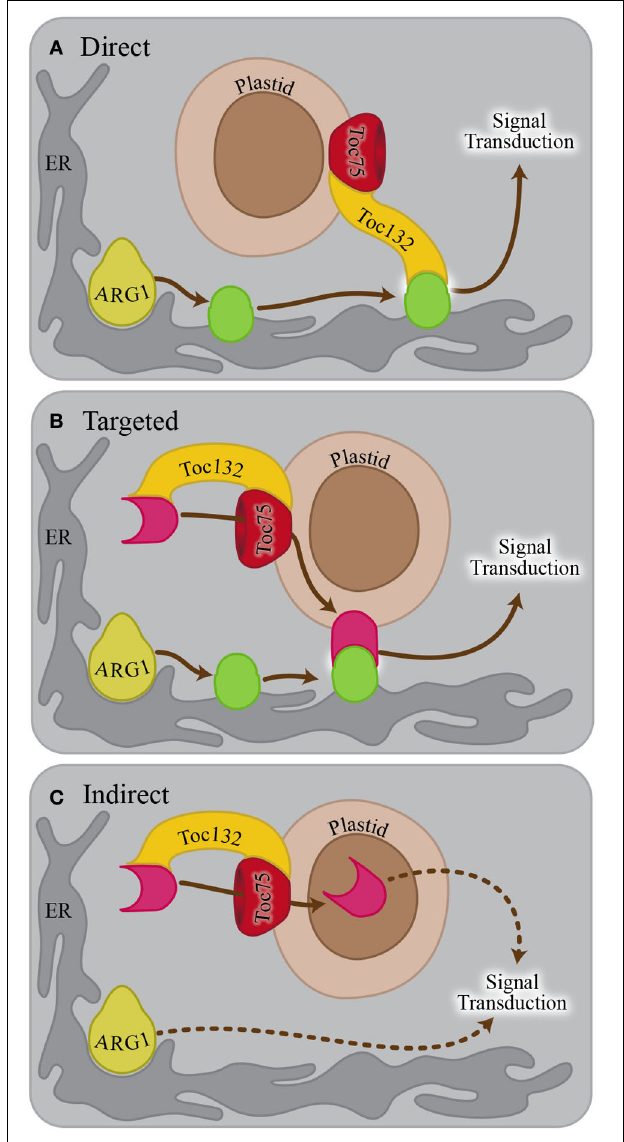
FIGURE 1 | Possible models explaining the genetic interaction between ARG1 and TOC132 . (A) In the direct interaction model, Toc132 acts as a ligand that interacts with a receptor (green oval) on the ER or plasma membrane. The localization or the activity of the receptor is mediated by ARG1. (B) In the targeted interaction model, Toc132 facilitates the plastid localization of a molecule acting as a ligand (pink shape) that interacts with a receptor (green oval) on the ER or plasma membrane upon amyloplast sedimentation. The localization or activity of the receptor is mediated by ARG1. (C) In the indirect interaction model, Toc132 facilitates the plastid localization of a molecule that does not act as a ligand but is still required for a gravitropic response in an arg1 background. In all three panels, the Toc33/34 receptor was omitted from the drawing for the sake of clarity and simplification of the